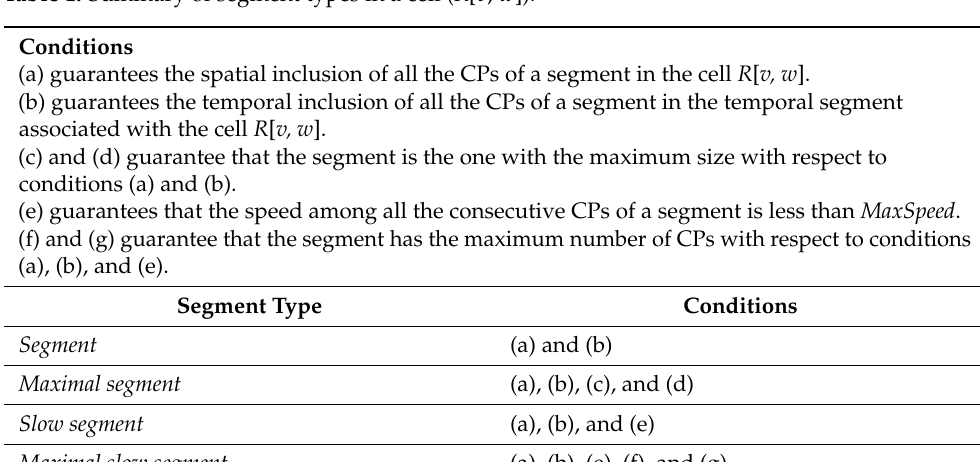
Table 1. Summary of segment types in a cell ( R [ v , w